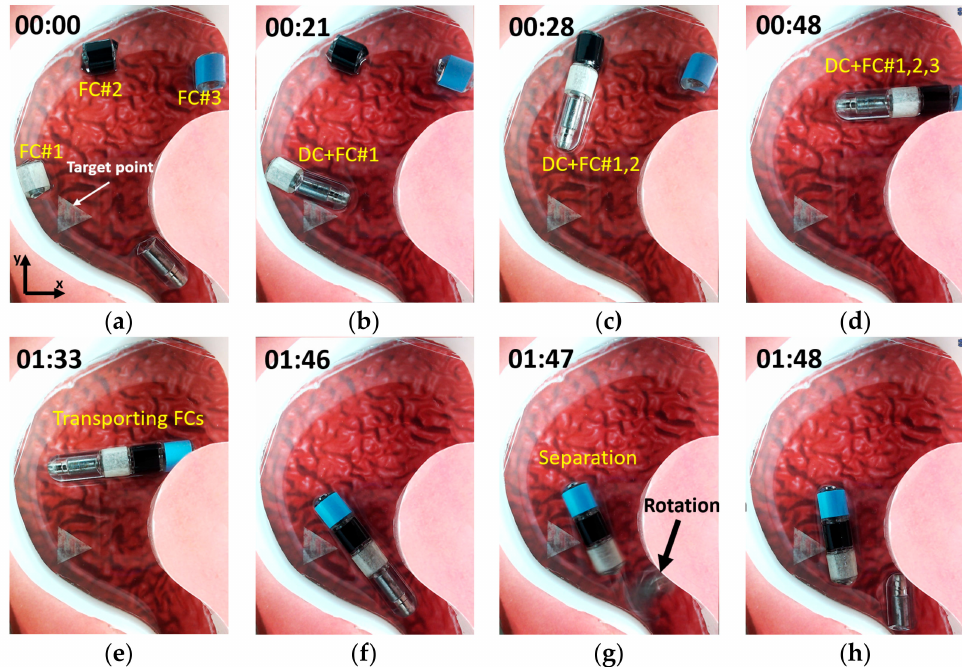
Figure 12. Experiment using stomach phantom. ( a ) Driving capsule locomotion. ( b – f ) Assembly and transporting of the functional capsules. ( g , h ) Separation motion of the modular capsules. A related video is provided in the Supplementary